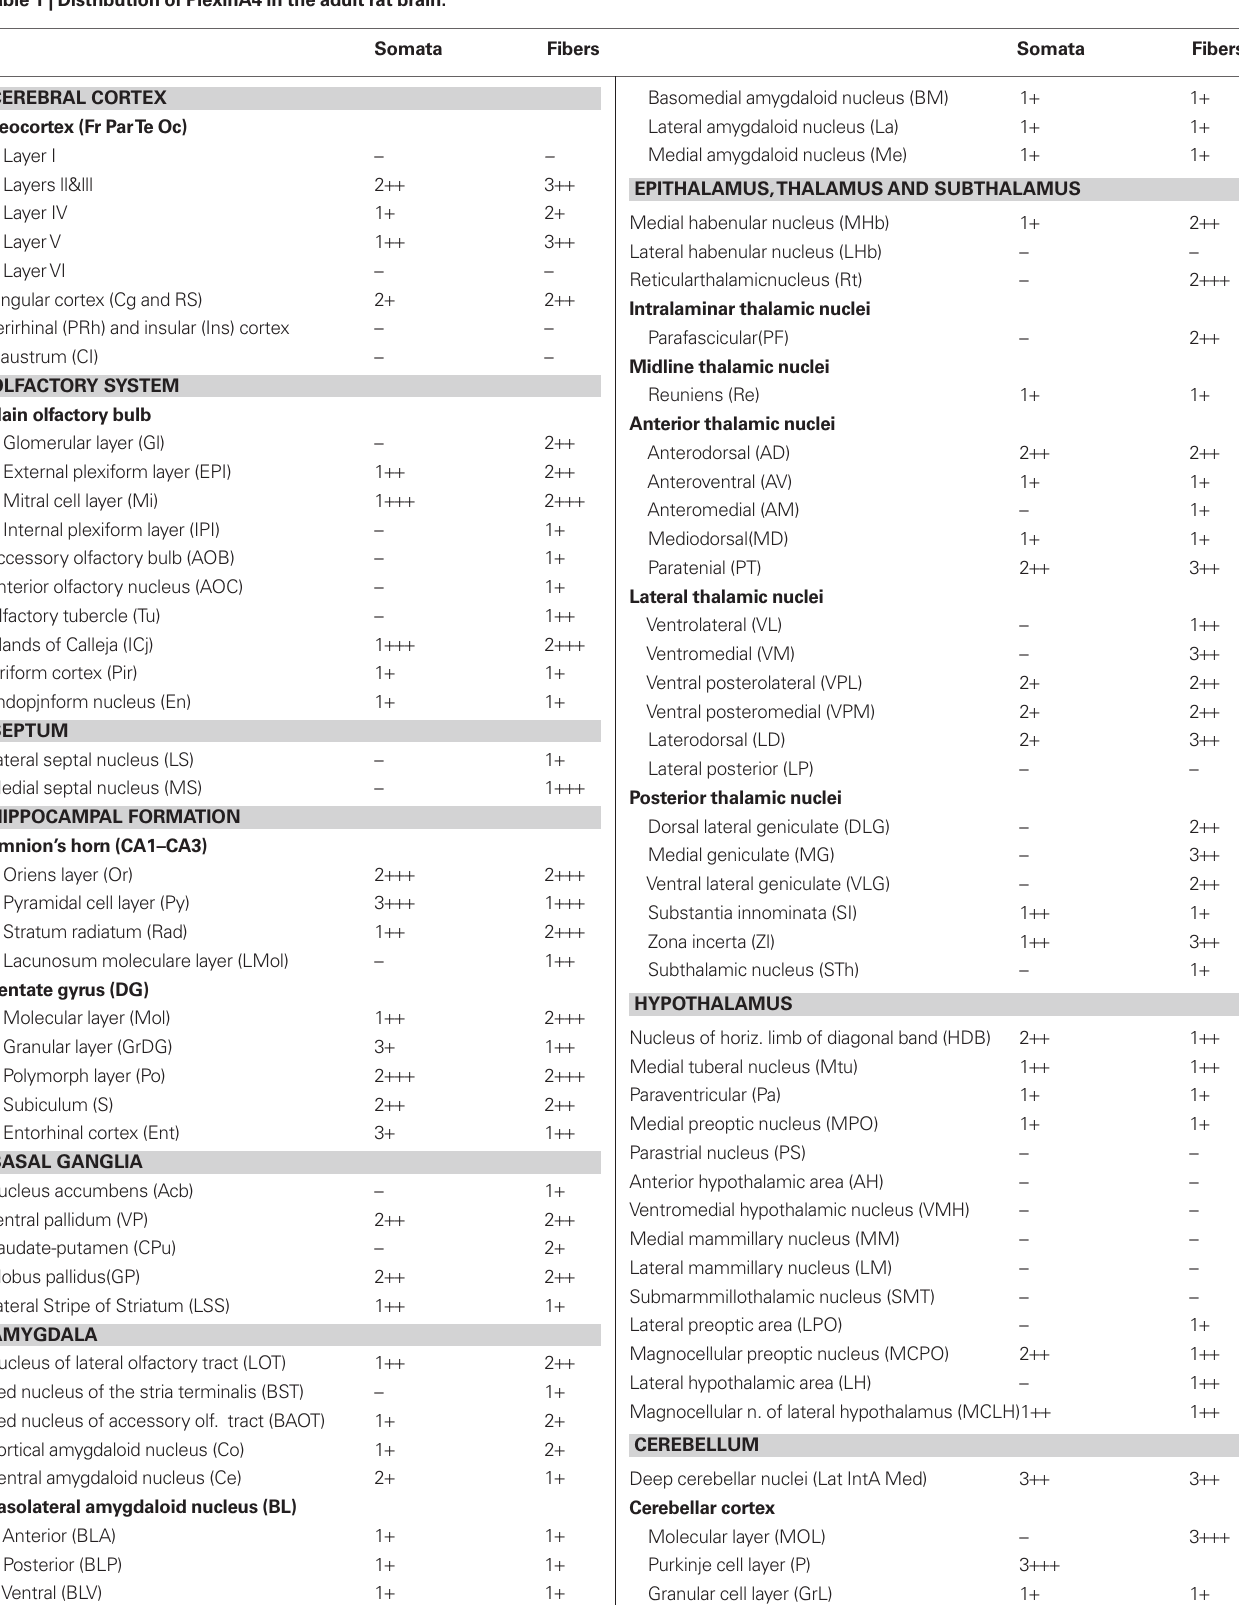
table 1 | Distribution of PlexinA4 in the adult rat